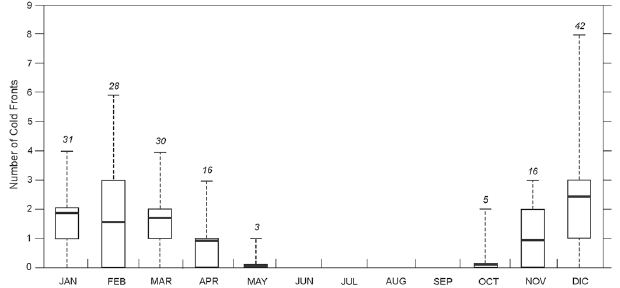
Fig. 7. Seasonal variation (box plot) of the number of cold fronts; values were estimated using data from 1996 to 2012.